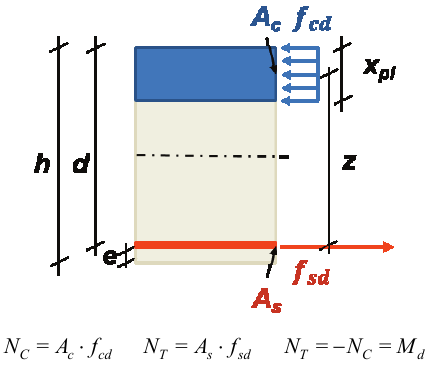
Fig. 21. Rectangular stress distribution model adopted for calculating reinforcement of the cross section for the wall